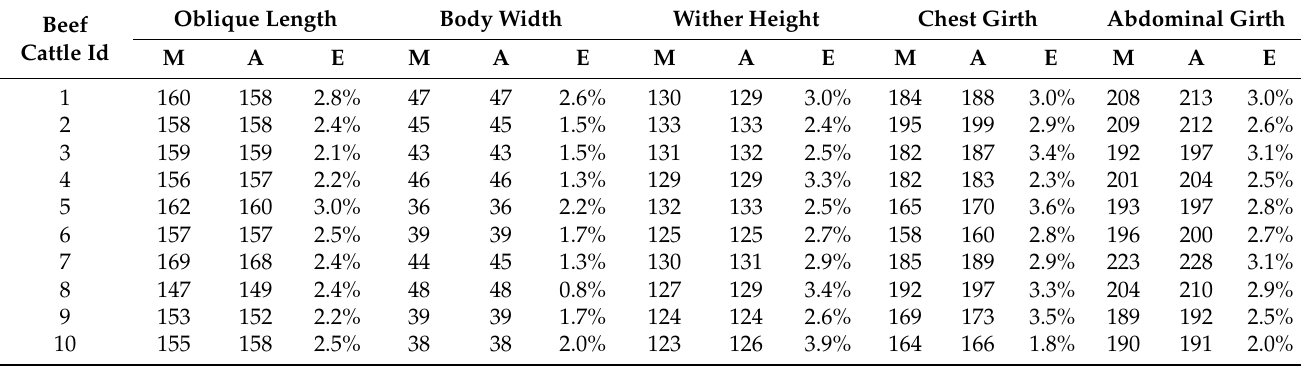
Table 2. Beef cattle body dimension measurement results.